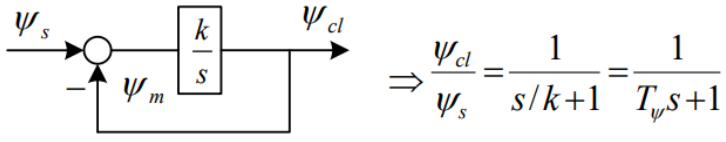
Figure 24. Measuring axis integral tracking strategy.